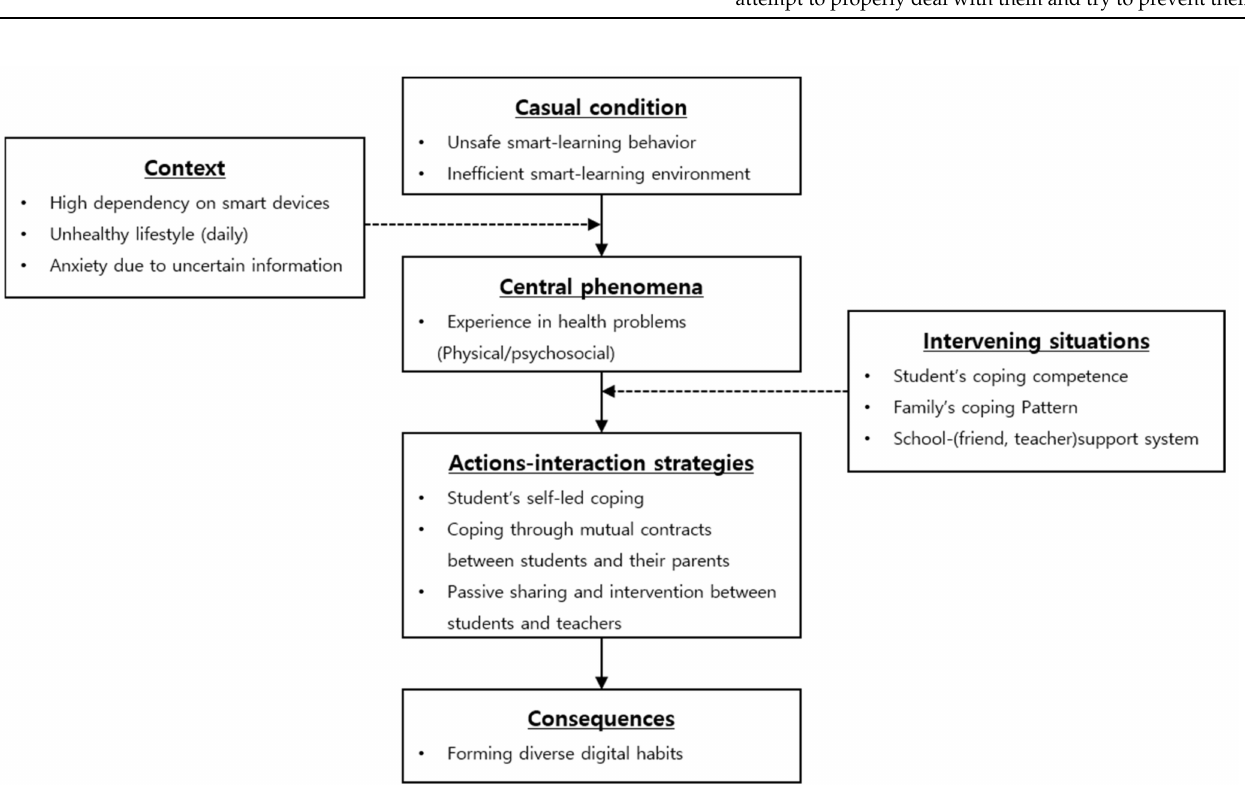
Figure 1. Paradigm model of health-related experiences with smart